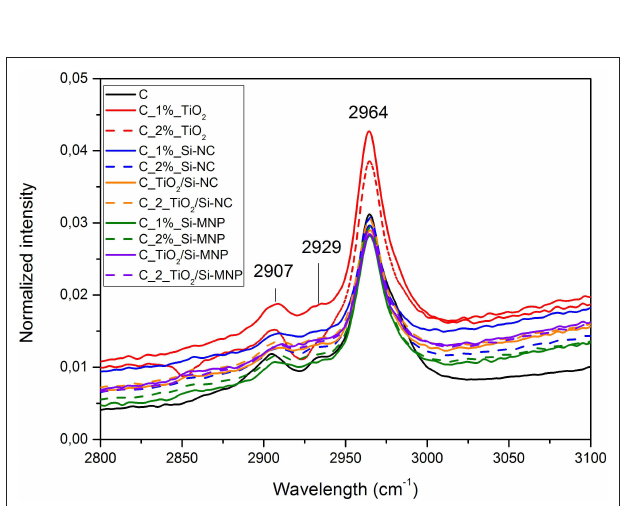
FIGURE 3 | Infrared spectra of all the coatings loaded with the different nanoparticles in the range between 2,800 and 3,100 cm − 1 .